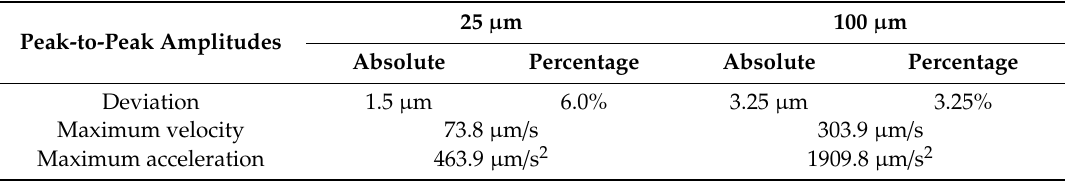
Table 1. Deviation, maximum velocity, and acceleration in a micromotion system with two sca ff olds and 1.7 mL DMEM